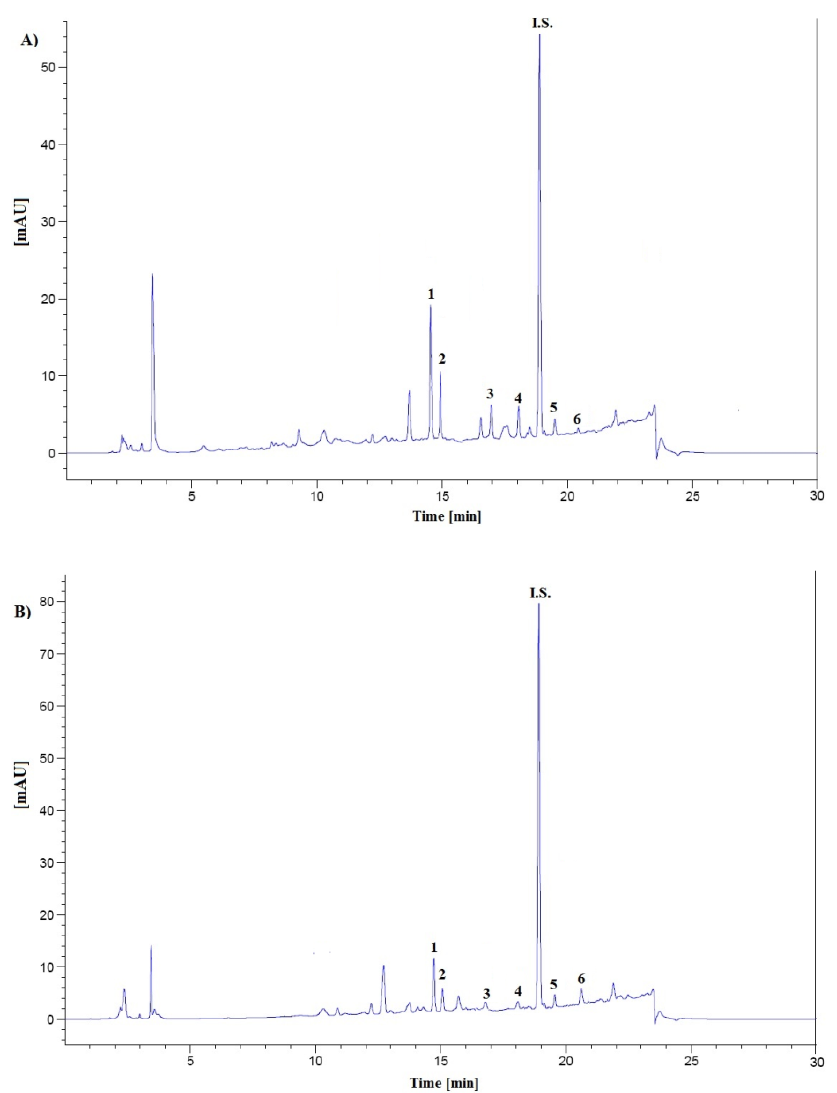
Figure 3. Representative LC chromatograms of human urine extract obtained from a healthy control (male) ( A ) and a patient with NETs (female) ( B ) at the level of cortisone ( 1 ); cortisol ( 2 ); corticosterone ( 3 ); testosterone ( 4 ); epitestosterone ( 5 ); progesterone ( 6 ): A—111.2; 108.1; 34.1; 11.6; 2.1; 1.4 ng mL − 1 ; B—57.1; 35.9; 2.8; 3.7; 1,4; 14.4 ng mL − 1 , respectively and methyltestosterone (I.S.) at a concentration of 100 ng mL − 1